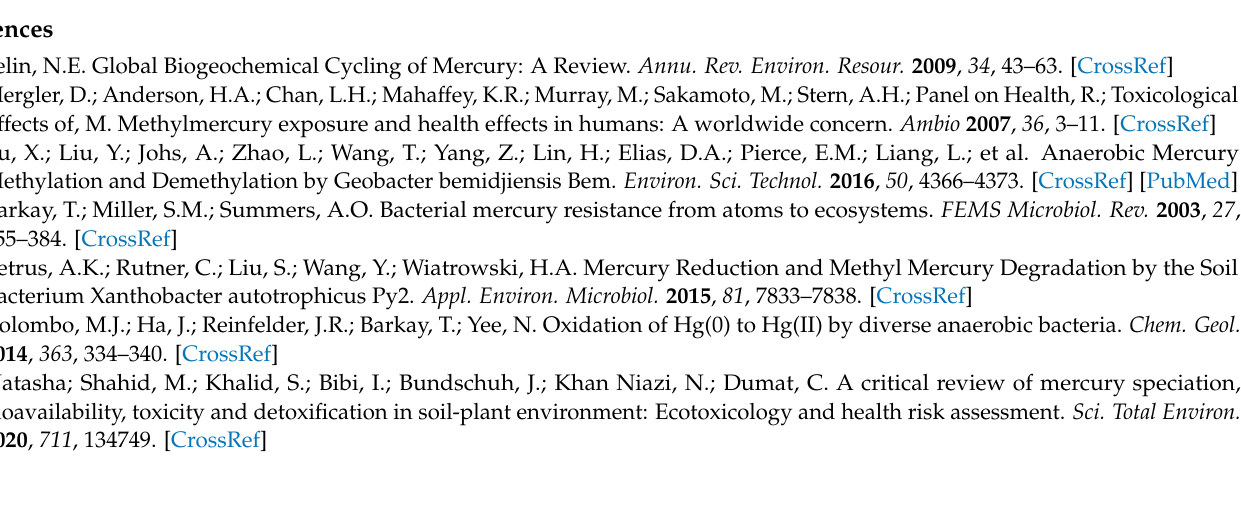
Table S2: Taxonomic distribution of the plasmid hosts, Table S3: The hosts, pathogenicity, and number of HRGs for 2006 plasmids, and Table S4: Co-distribution of HRGs and ARGs in each